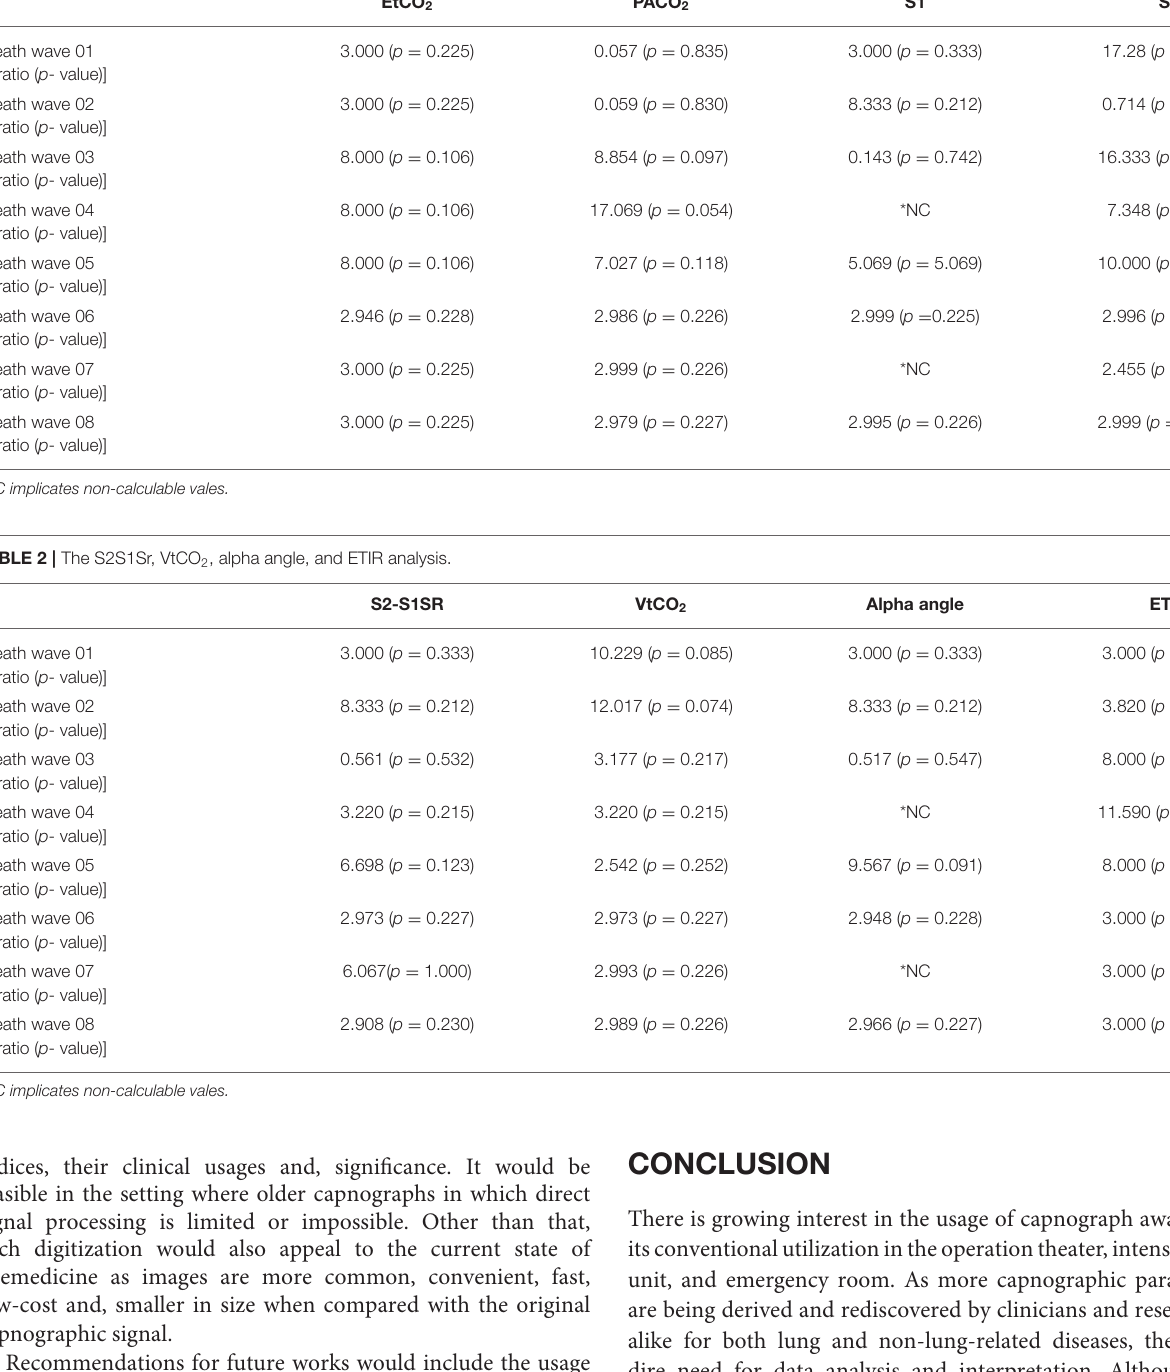
TABLE 1 | The EtCO 2 , PACO 2 , S1, and S2 analysis.